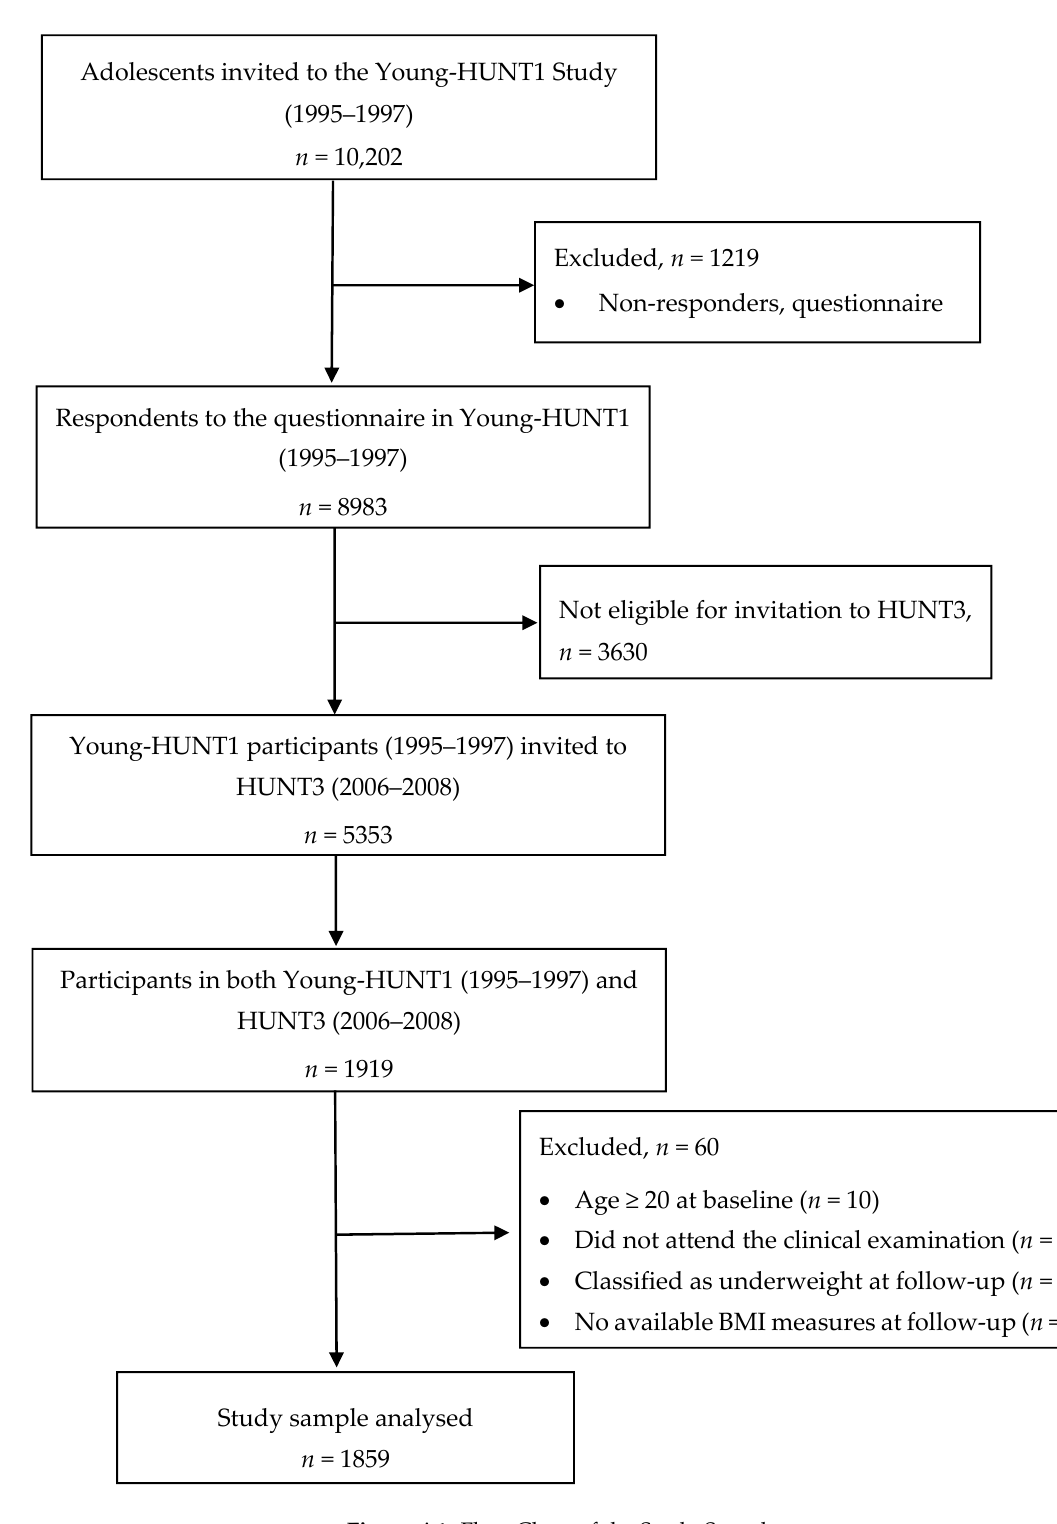
Figure A1. Flow Chart of the Study